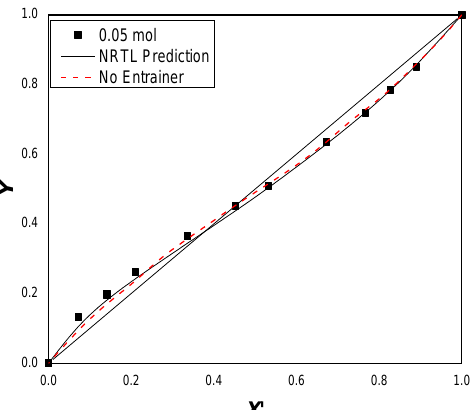
Figure 14. FT − IR spectra of DES(1:1), benzene and DES(1:1) + benzene(DES 0.1 (molar concentra- tion)).